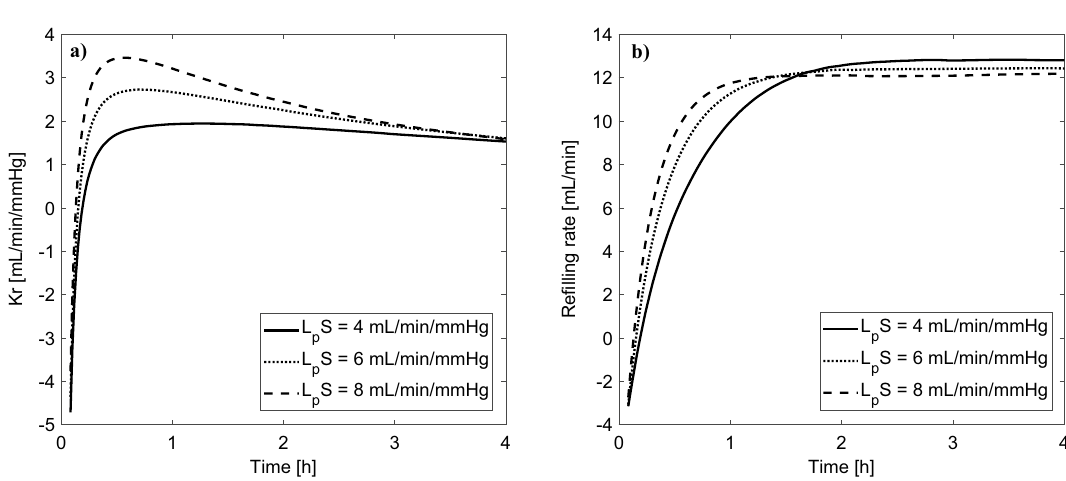
Figure 4. Simulated changes of ( a ) vascular refilling coefficient (Kr) and ( b ) vascular refilling rate (the sum of transcapillary fluid absorption and the total flow of lymph) during 4 h hemodialysis sessions with different values of the whole-body capillary hydraulic conductivity (L p S), with the priming saline infused to the